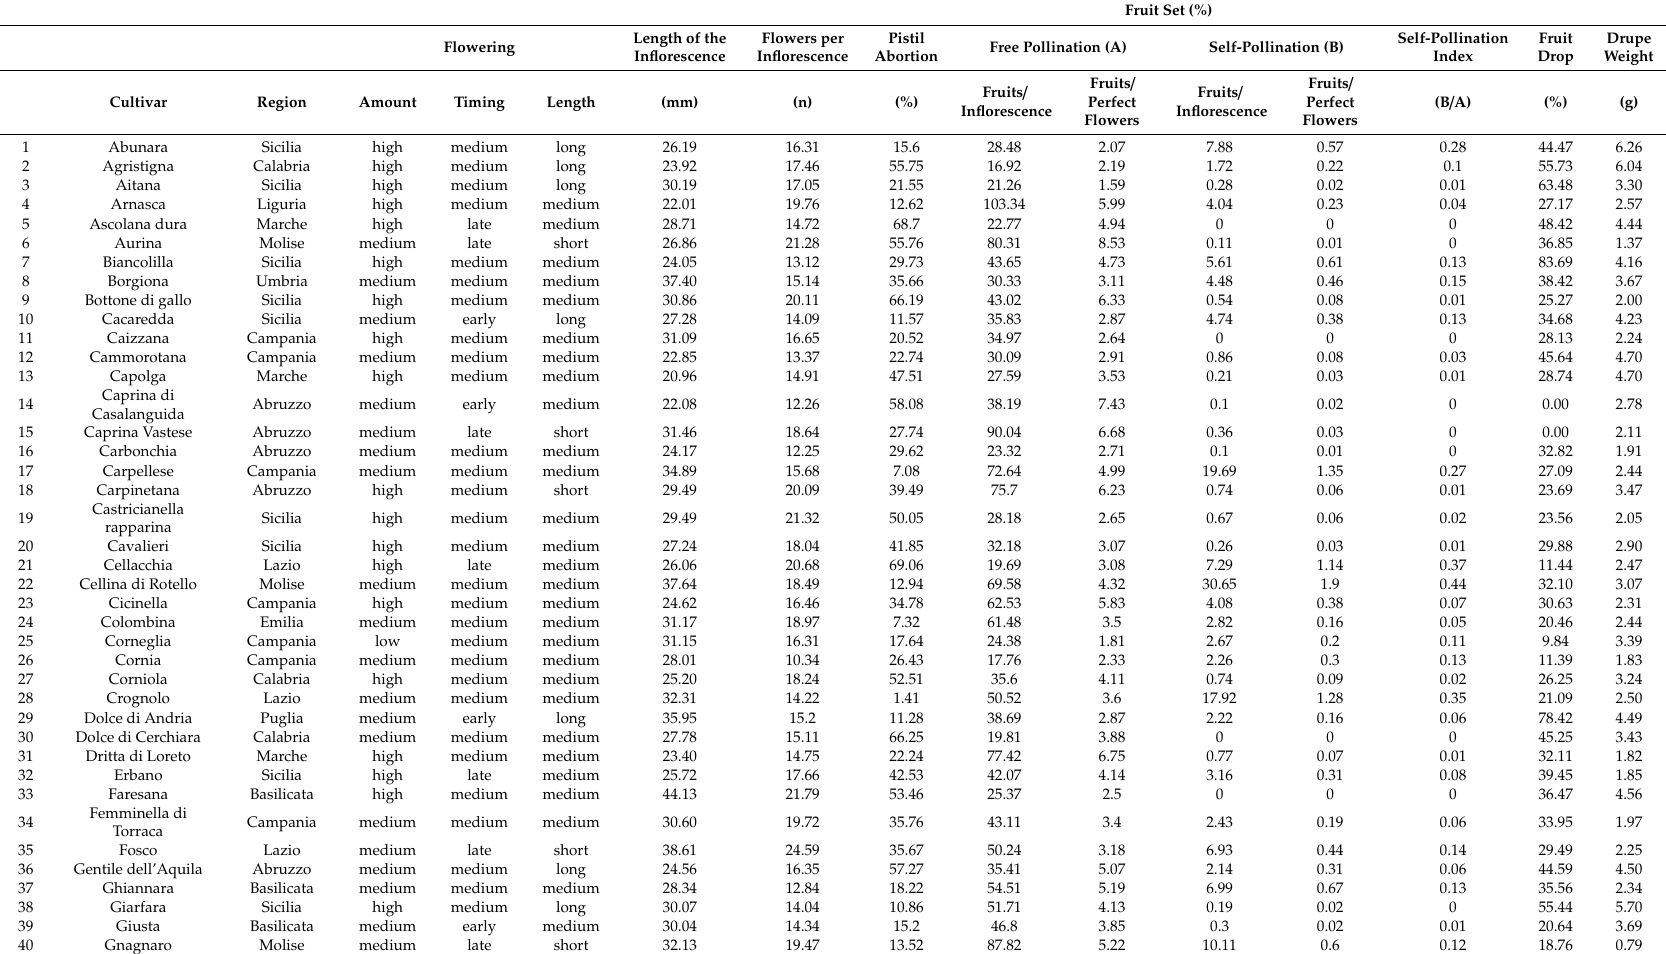
Table 1. Characteristic of the examined parameters for the 120 olive varieties with the indication of their regions of